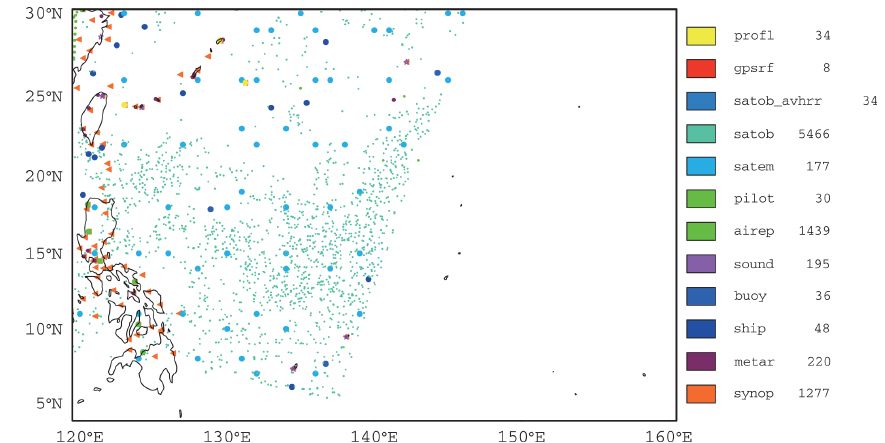
Figure 4. Distribution of GTS observations in the simulated area at 00:00UTC on 2 August 2015. On the right side of the map are the name of observation data and the number of observations. Each observation type is marked with a different color along with a unique symbol.